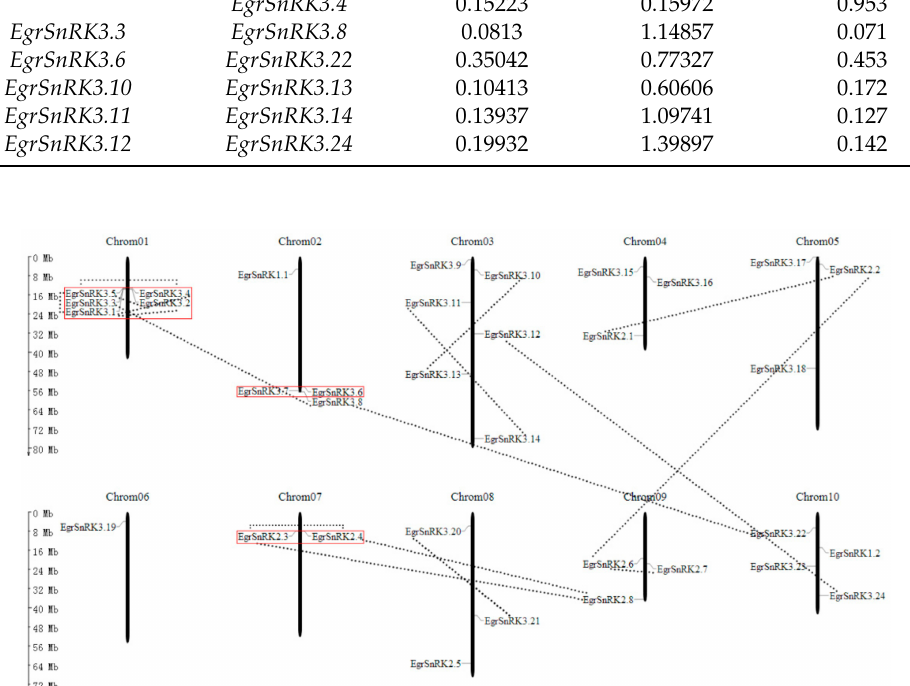
Figure 5. Chromosomal location of EgrSnRK genes. The 34 EgrSnRK genes are widely mapped to 10 of the 11 chromosomes. The paralogous pairs of EgrSnRK genes are connected by gray-dotted lines. The red boxes in front of the genes on behalf of these genes belonging to a gene